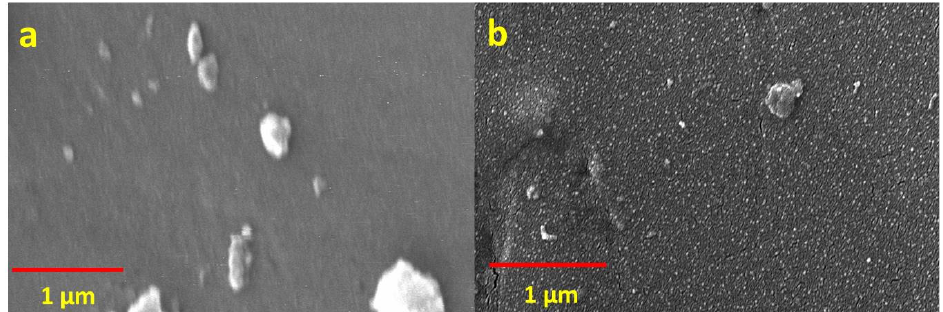
Figure 5. SEM images of CF–epoxy composites with and without NDs. ( a ) Neat epoxy matrix; ( b ) epoxy matrix containing NDs.